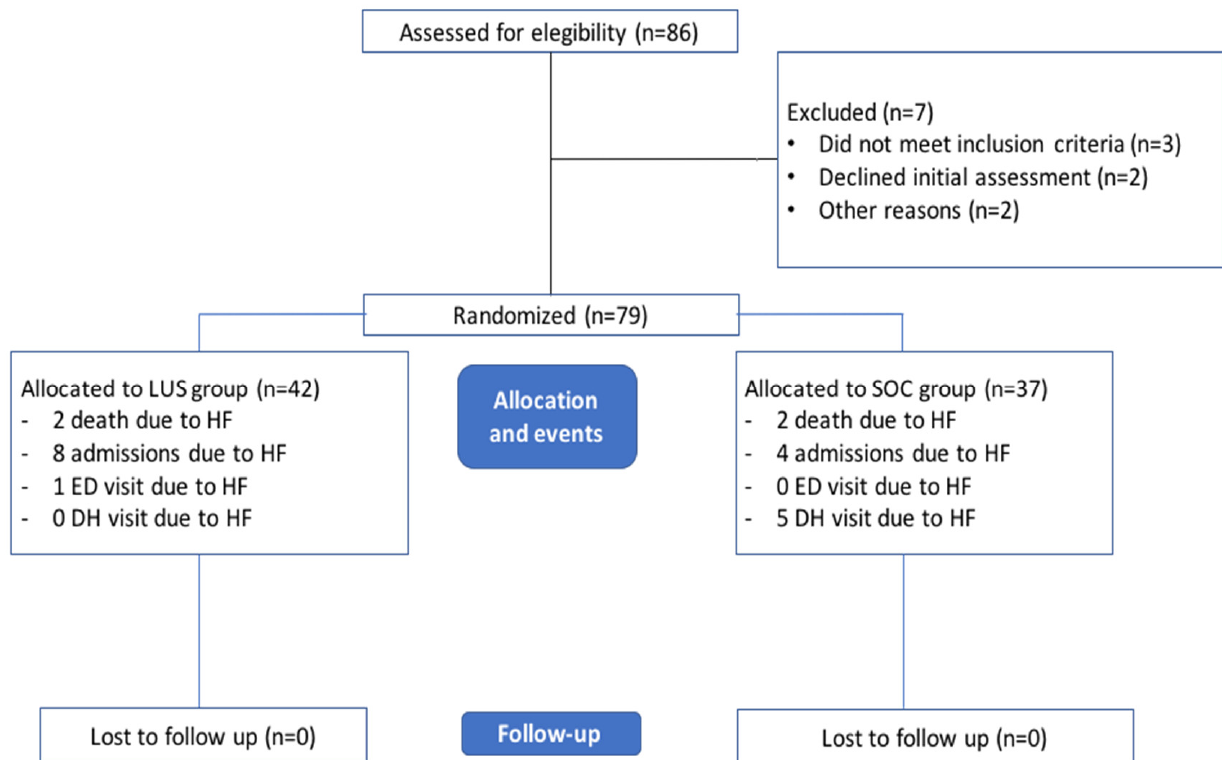
Figure 1. Patient selection flowchart. LUS, lung ultrasound; SOC, standard of care management group.